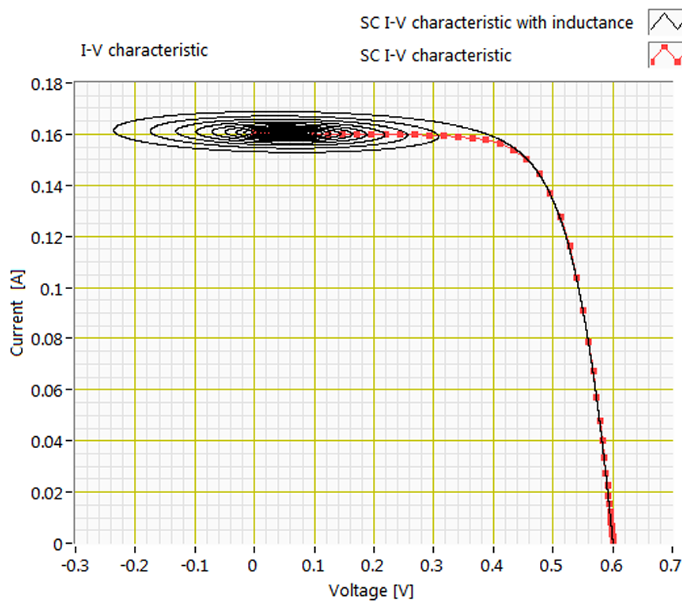
Figure 5. The voltage and current waveforms obtained in simulation ( C p = 0.433 μF, R sh = 777 Ω, L 1 = 566 μH, R s = 143 m Ω, R 1 = 100 m Ω).